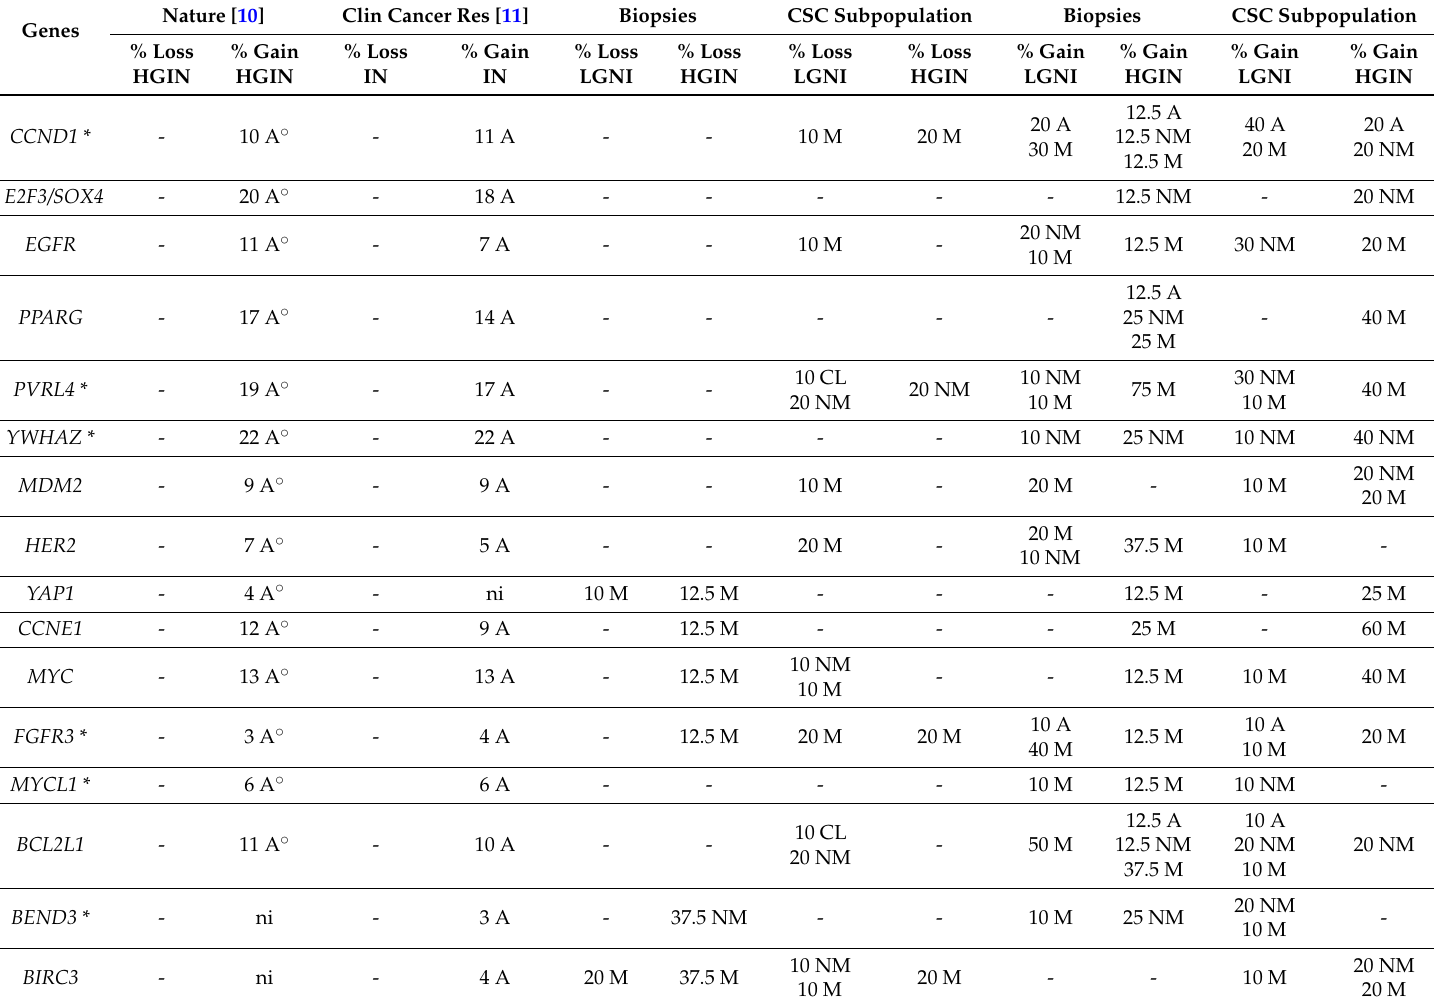
Table 1. Array comparative genomic hybridization (array-CGH) results. Comparison with